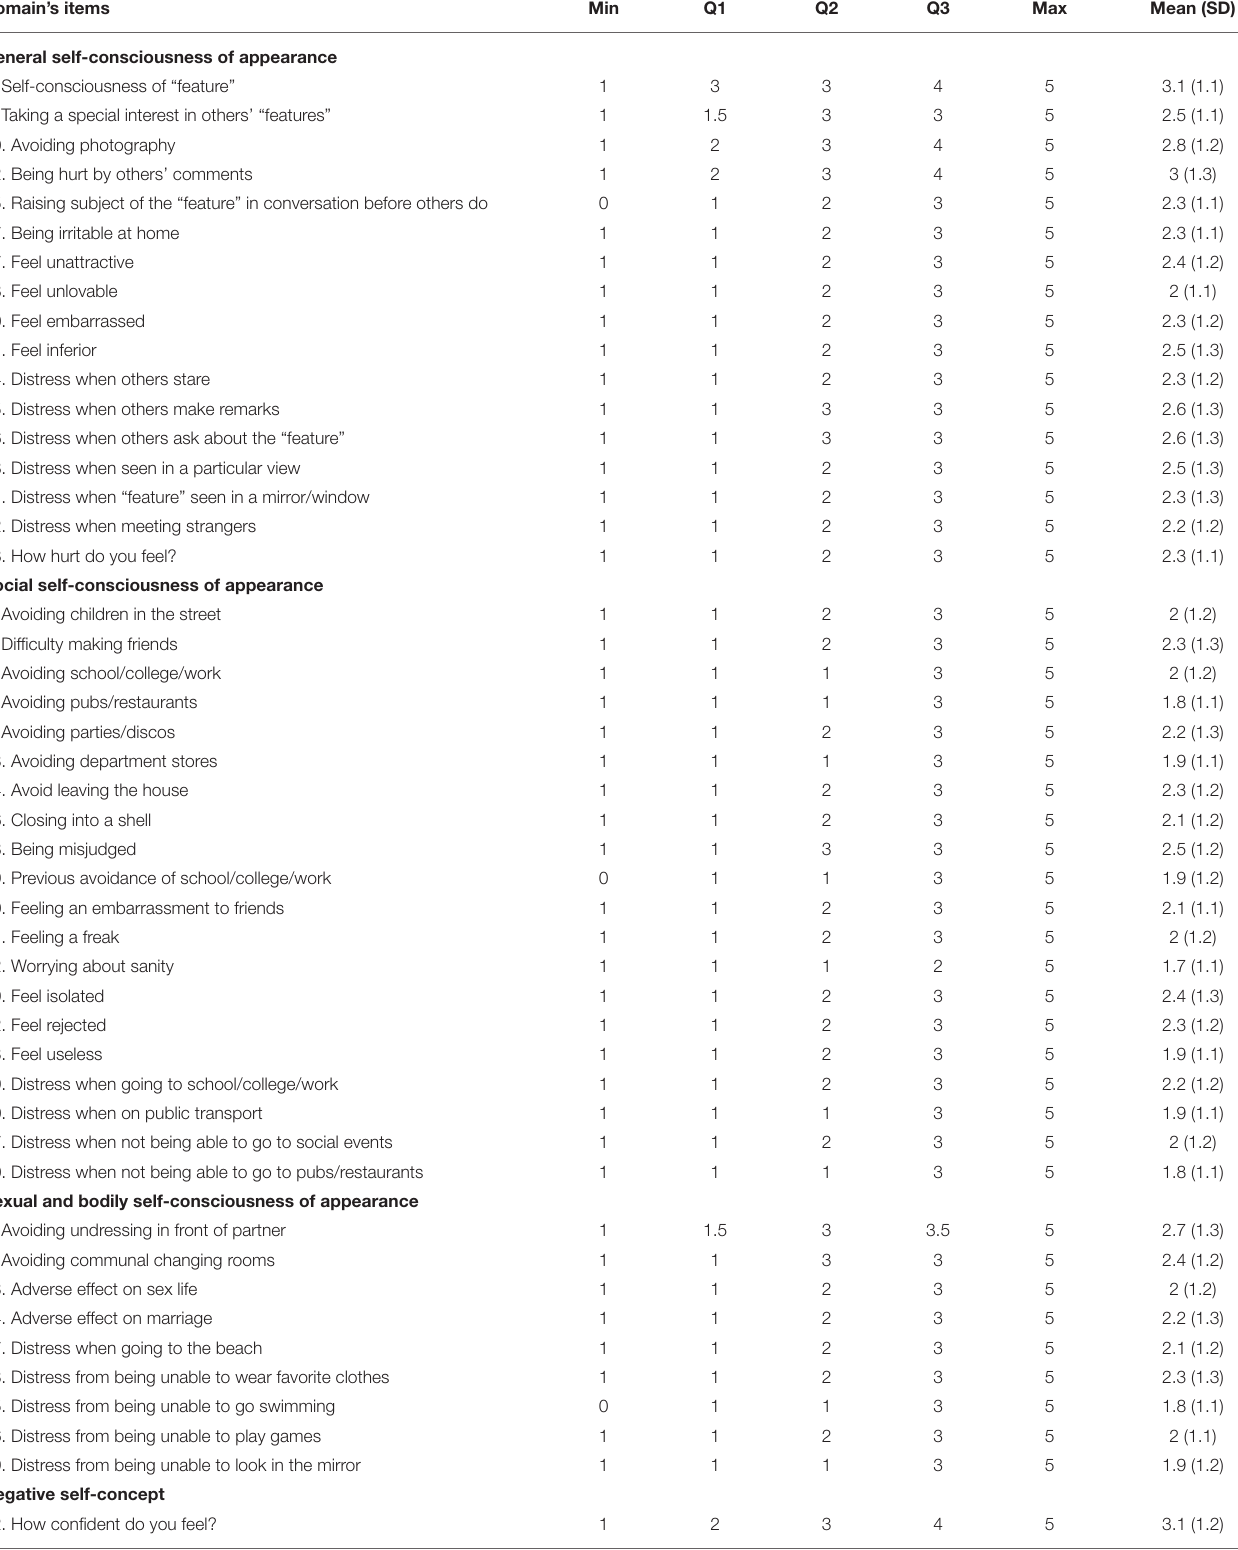
TABLE 6 | Score of domain’s items of DAS 59 scale in patients with cleft lip. Domain’s